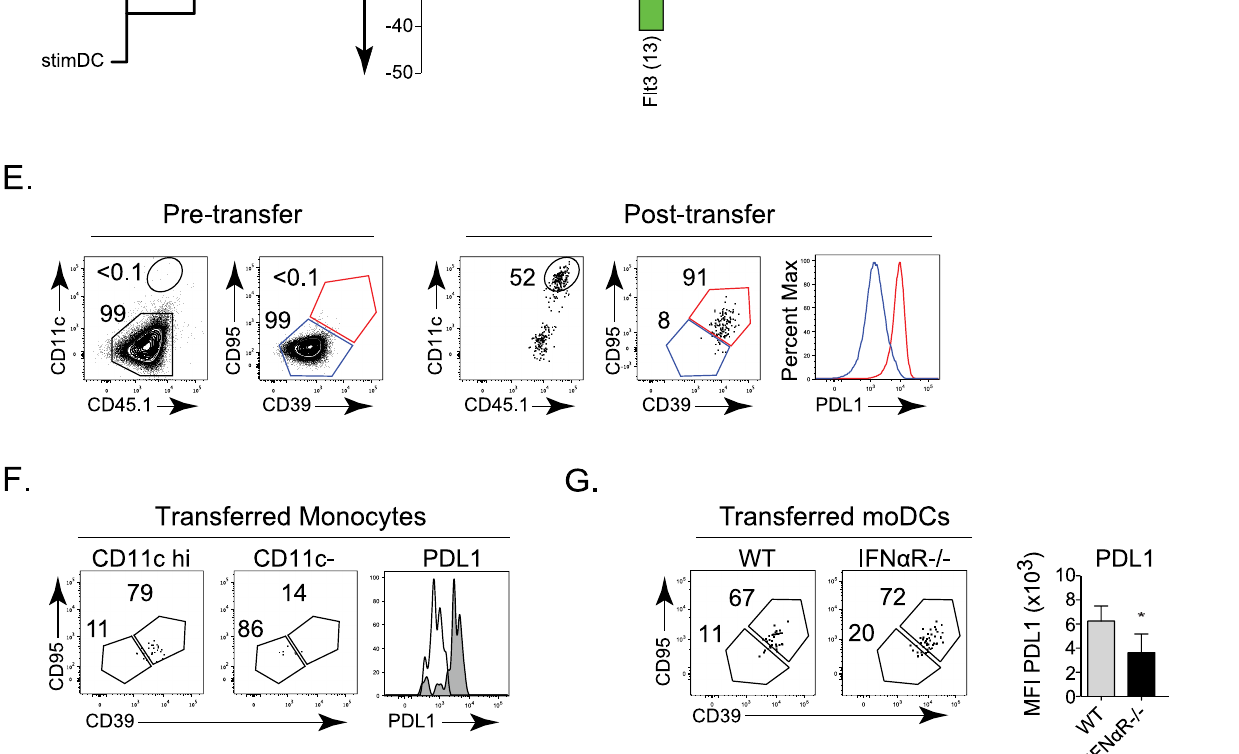
PLOS Pathogens | DOI:10.1371/journal.ppat.1005356 January 25, 2016 11 /